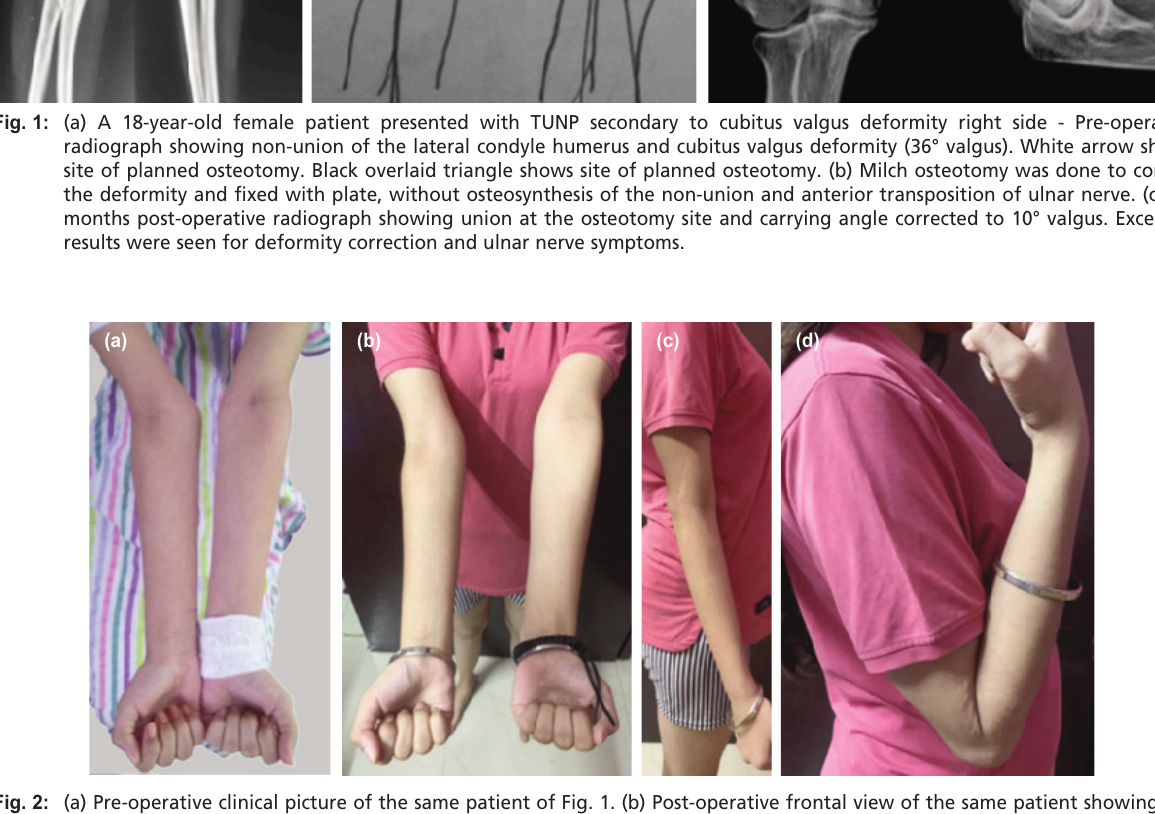
(a) Pre-operative clinical picture of the same patient of Fig. 1. (b) Post-operative frontal view of the same patient showing the Fig. 2: deformity correction. (c) Post-operative side view showing full extension. (d) Post-operative side view showing full